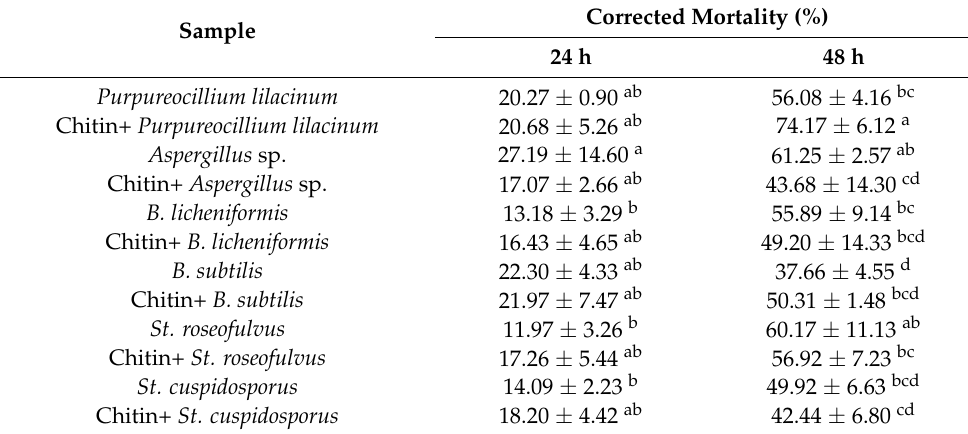
Table 1. Effect of chitin on the nematicidal activity of selected biocontrol microorganisms against M. incognita J2s in vitro.